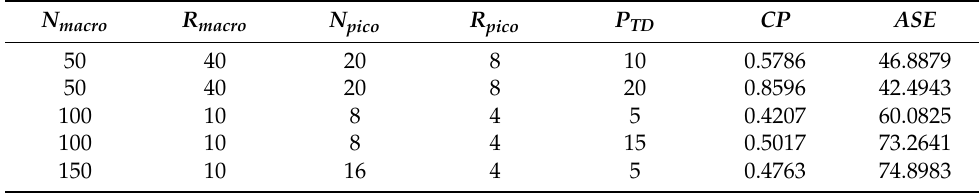
Table 2. Initial five rows of the prepared